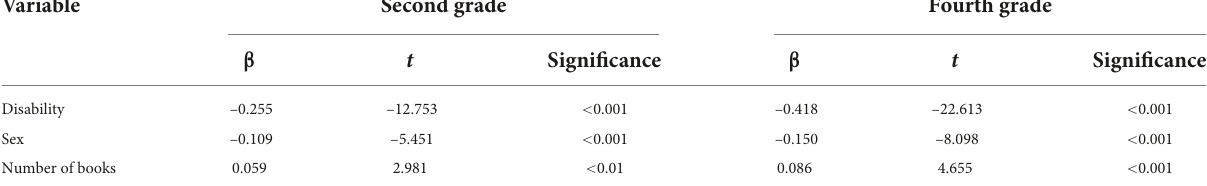
TABLE 3 Reading Comprehension by the presence of disability, sex, and number of books at home.